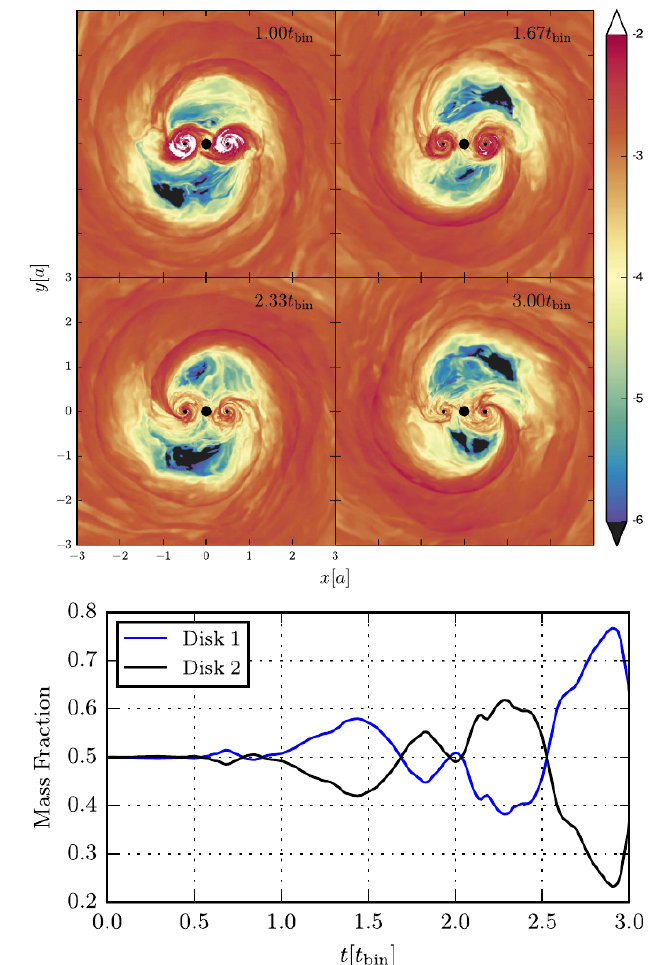
Figure 2. Rest-mass density (linear color scale) from a GRMHD simulation in a spacetime framework similar to [69,72] ( upper panel ) and individual disk masses as a function of orbital phase ( lower panel ). One can clearly see in the lower panel, that mass is sloshing back and forth between the two mini disks. This effect is shown to persist over longer time scales in the follow-up work